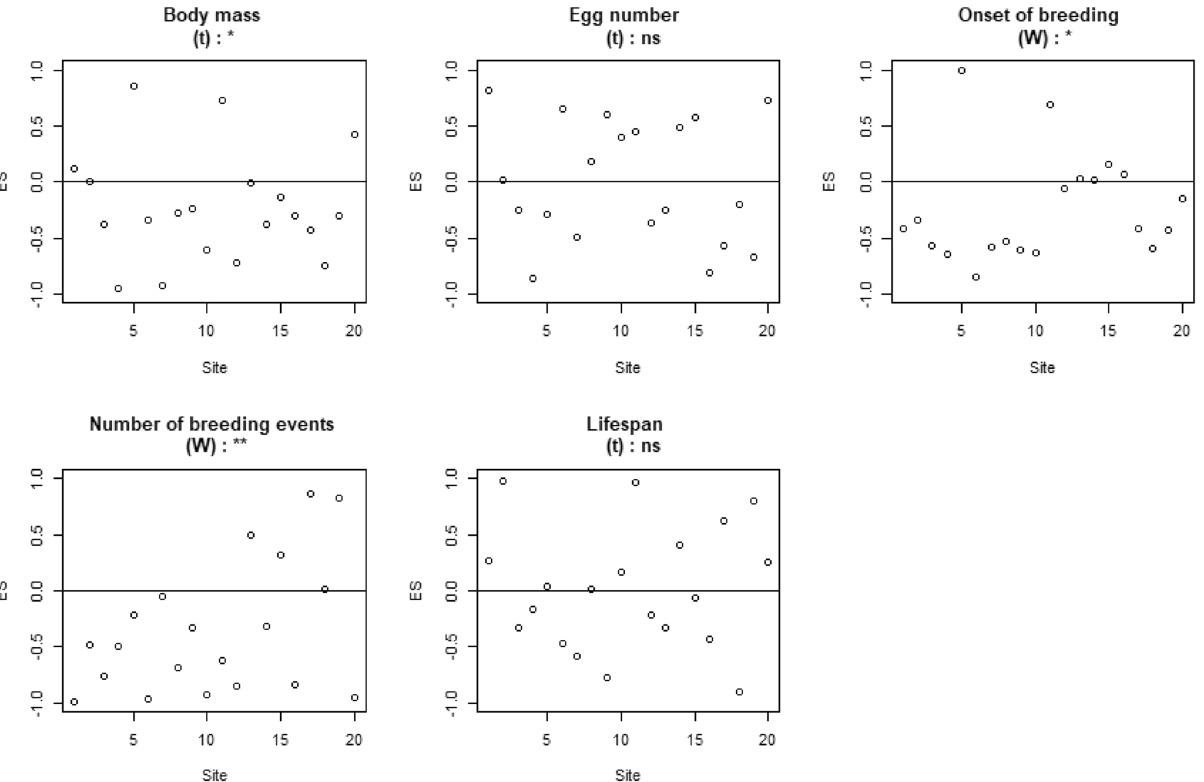
Figure 4. Effect size (ES) of bird assemblages obtained using the “species occurrence rate model” (NM2) for each of the five traits: body mass, egg number, onset of breeding, number of breeding events and lifespan. Significance levels (***p < 0.001, **p < 0.01, *p < 0.05) and non-significance (ns) of the Wilcoxon tests (W) or Student’s t tests (t) are presented on top of each graph. Df = 19. This figure was created using R Software 81 (v. 4.02, https ://www.r-proje